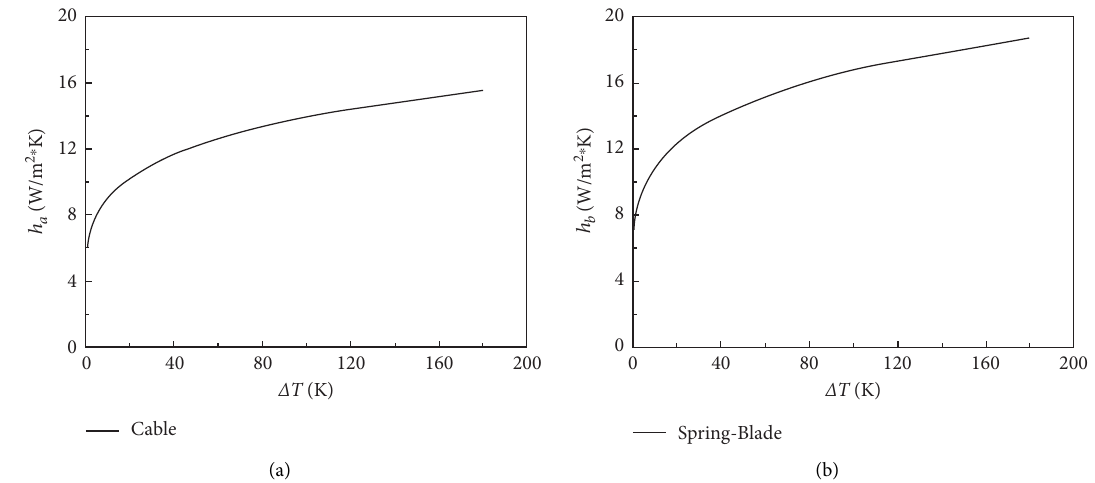
Figure 7: The relationships between h and Δ T . (a) h